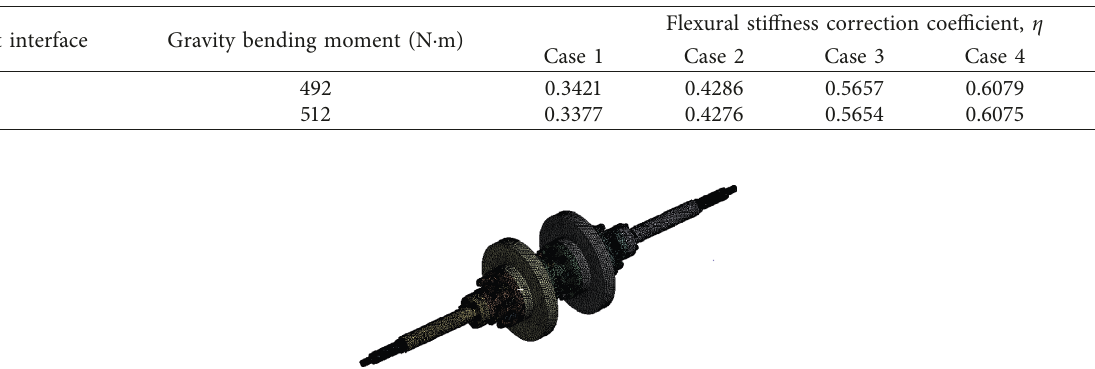
Table 3: Flexural stiffness corrections under different pretightening forces.